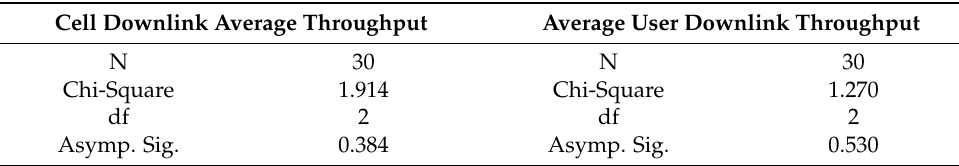
Table 12. Results of Friedman test for two dependent variables. Cell Downlink Average Throughput Average User Downlink Throughput